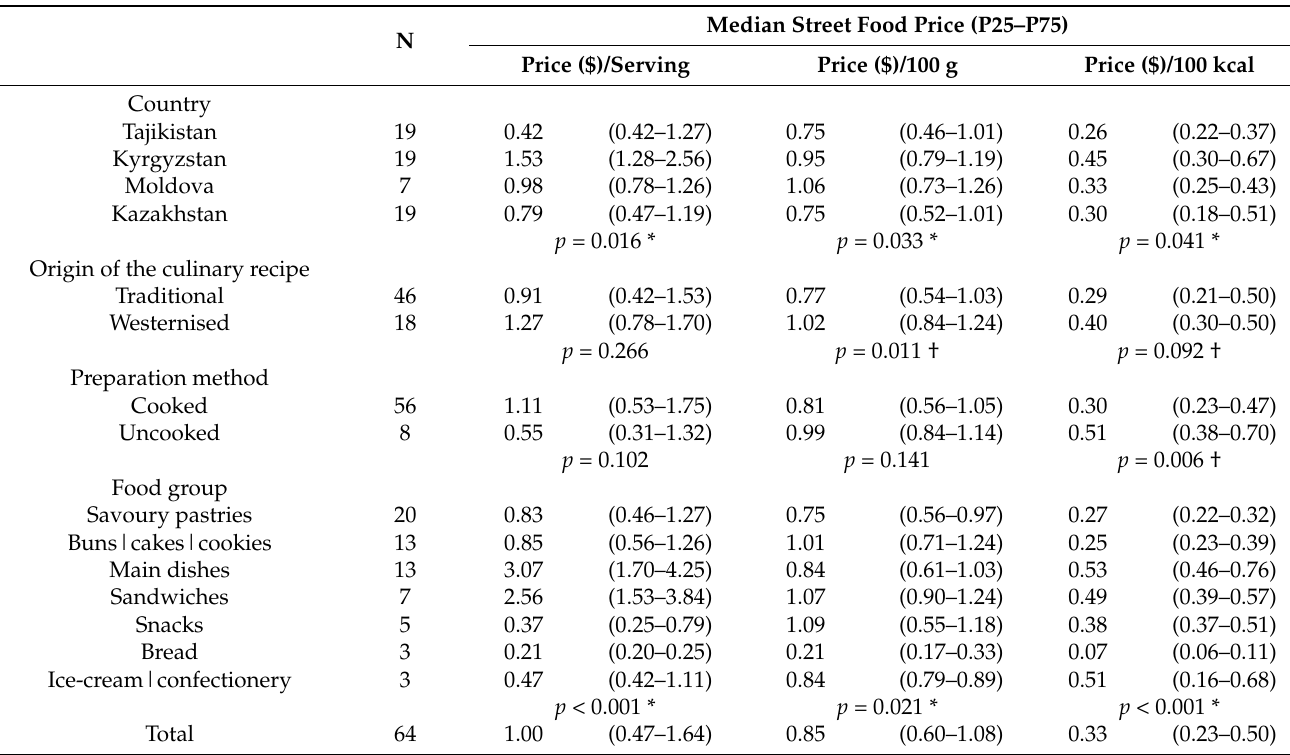
Table 1. Prices of street food by country and food characteristics, according to three metrics: price per serving, per 100 g and per 100